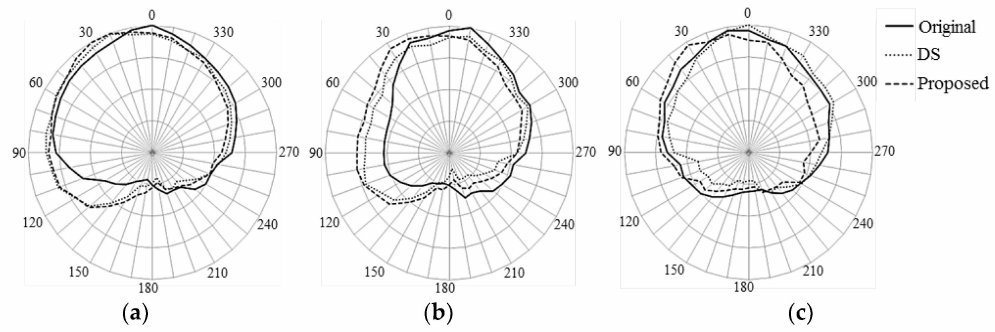
Figure 10. Comparison of directivity pattern of the original source with those obtained by the DS beamformer and the proposed method in three different environments: ( a ) anechoic; ( b ) convolutive; and ( c ) real reverberant